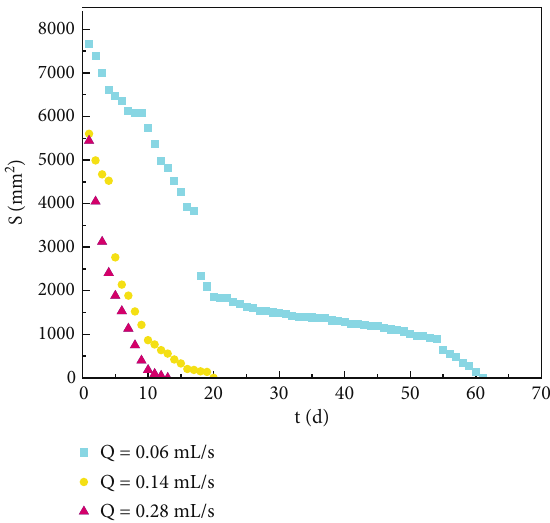
Figure 15: Dissolution process of PCE in the fracture model.